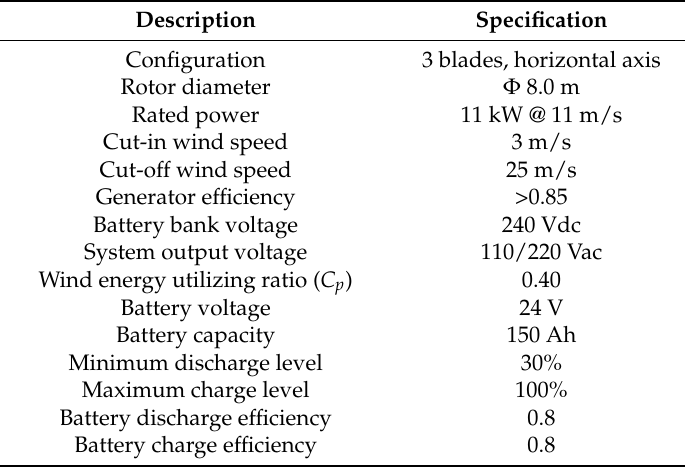
Table 1. Wind turbine and energy storage specifications.